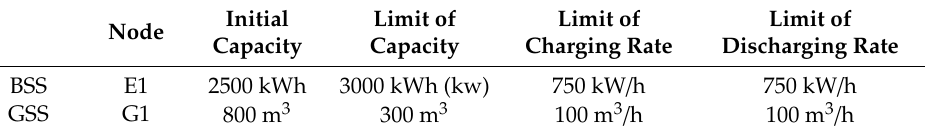
Table 7. Parameters of energy storage